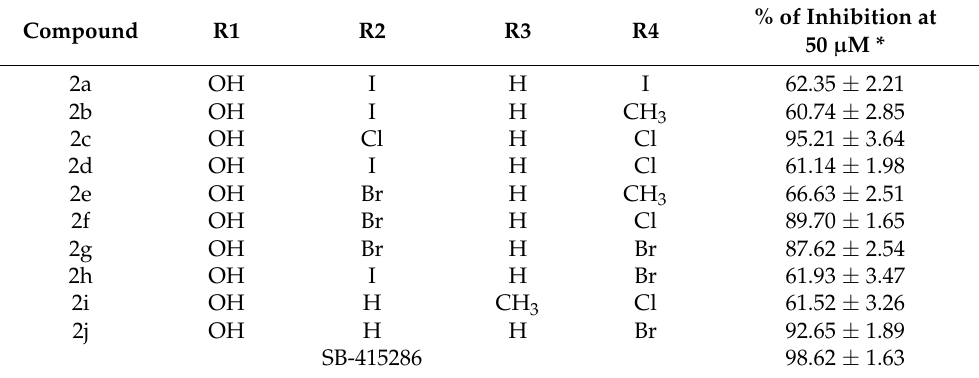
Table 5. Screening of the title compounds for their potency to inhibit GSK-3 β (50 µ M). Compound